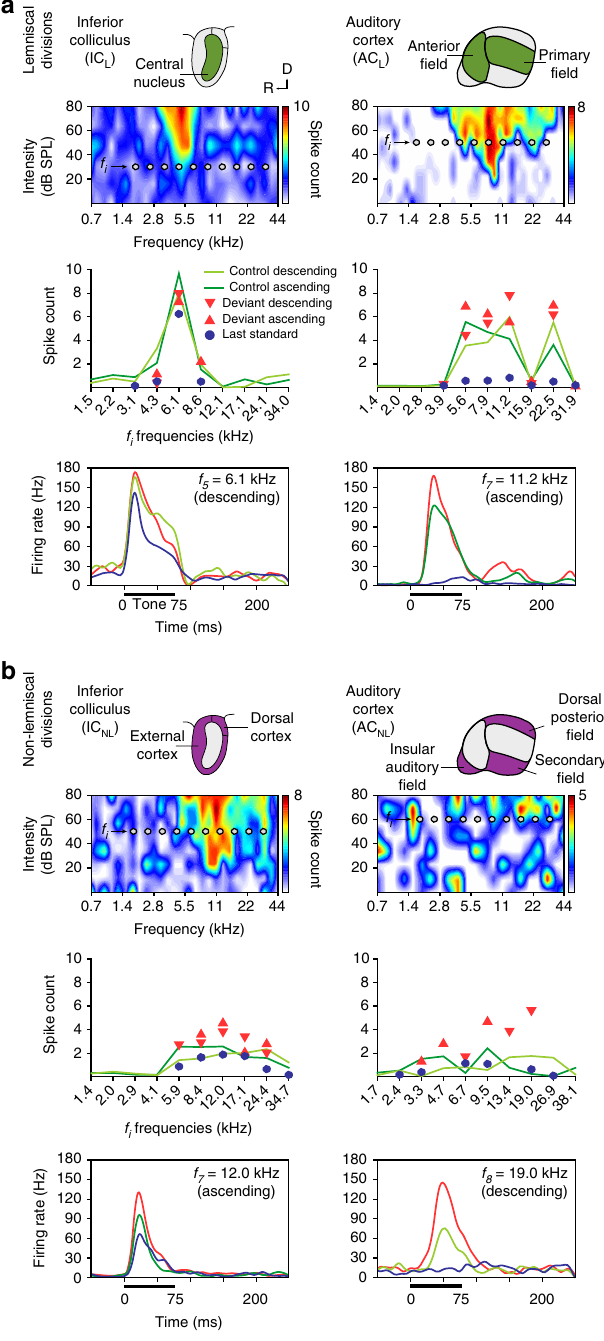
Fig. 6 Prediction error in representative examples of neuronal responses in awake mouse. a Examples of lemniscal multiunit activity recorded in two auditory nuclei (columns). The fi rst row contains schematics of the lemniscal subdivisions (green) within each station. The second row shows a frequency-response area of each nuclei. Ten grey dots within those frequency-response area represent the ten tones (f i ) selected to build the experimental sequences (see Methods). The third row displays the measured responses to each fi tone (baseline-corrected spike counts, averaged within 0 – 180 ms after tone onset) for all conditions tested. The fourth row contains sample peri-stimulus histagrams comparing the neuronal responses to each condition tested for an indicated f i tone. Stimulus duration is represented by a thick horizontal line. b Examples of multiunit activity recorded in non-lemniscal divisions ( fi rst row, colored purple) of each auditory nuclei, organized as in